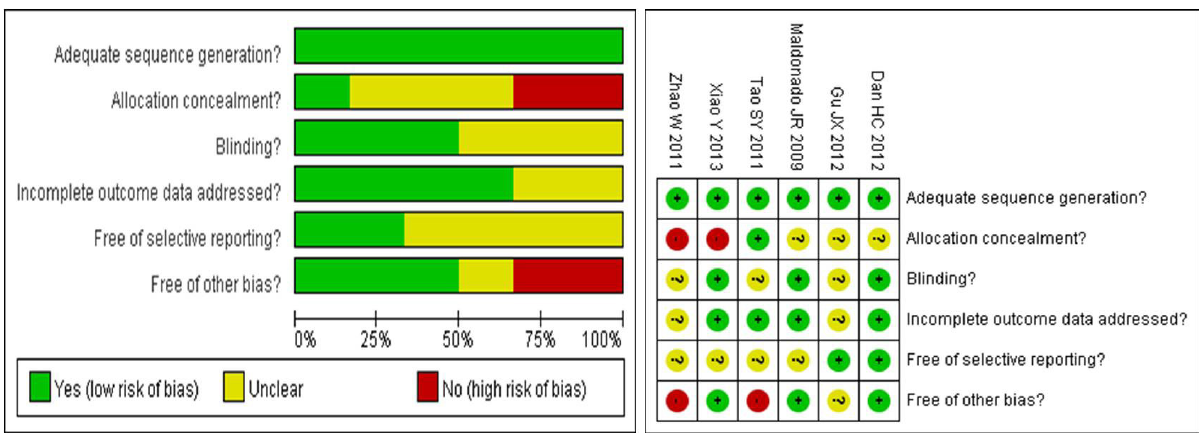
Figure 2: General quality of the included 6 studies.( “+/Yes” for low risk; “-/No” for high risk; “?” for moderate risk)